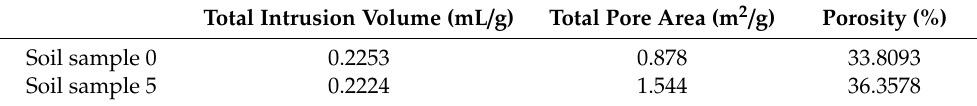
Figure 8. Density curve of pore size distribution. Table 3. Intrusion data summary.